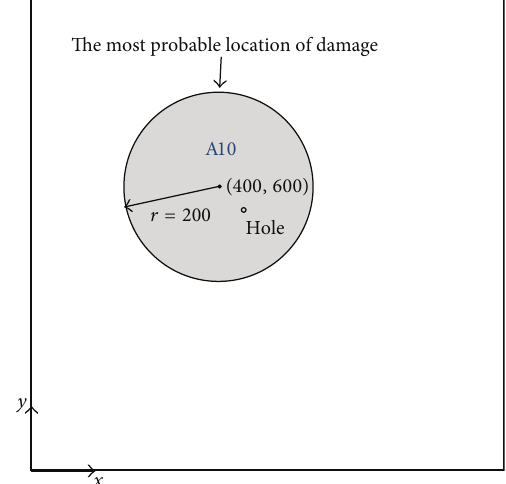
Figure 9: The most probable location of damage in aluminum plate with through-thickness hole.